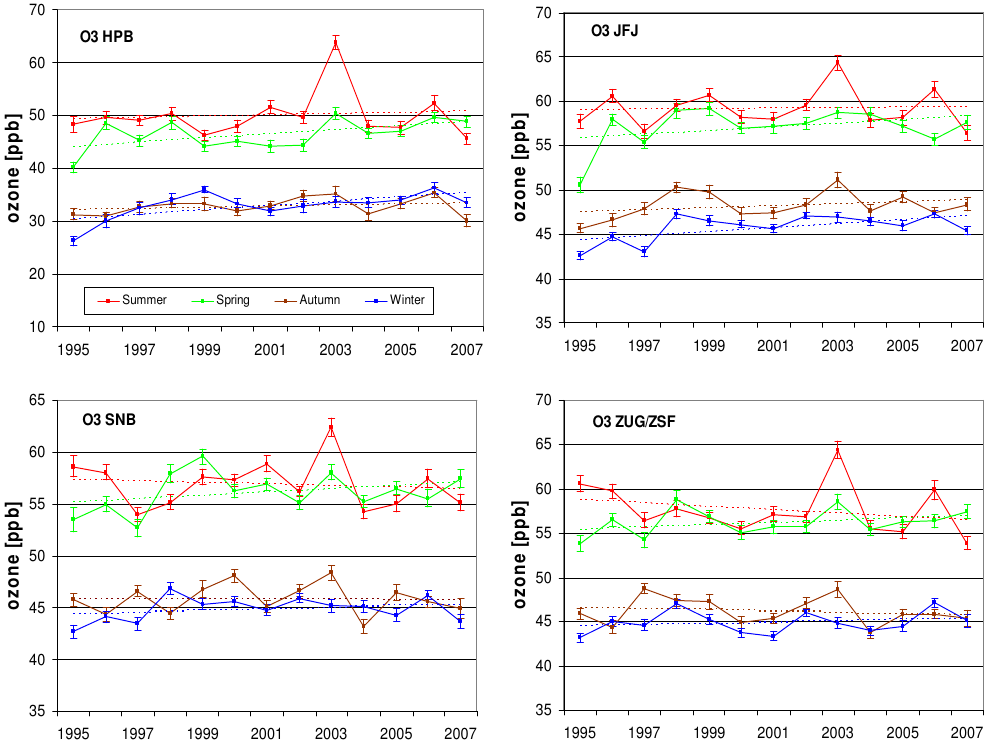
Fig. 5. O 3 time series since 1995 for the different seasons at the respective “DACH” sites; blue: winter; green: spring; red: summer, brown: autumn yearly mean mixing ratios with standard error of the mean (solid) and linear trend (dashed).